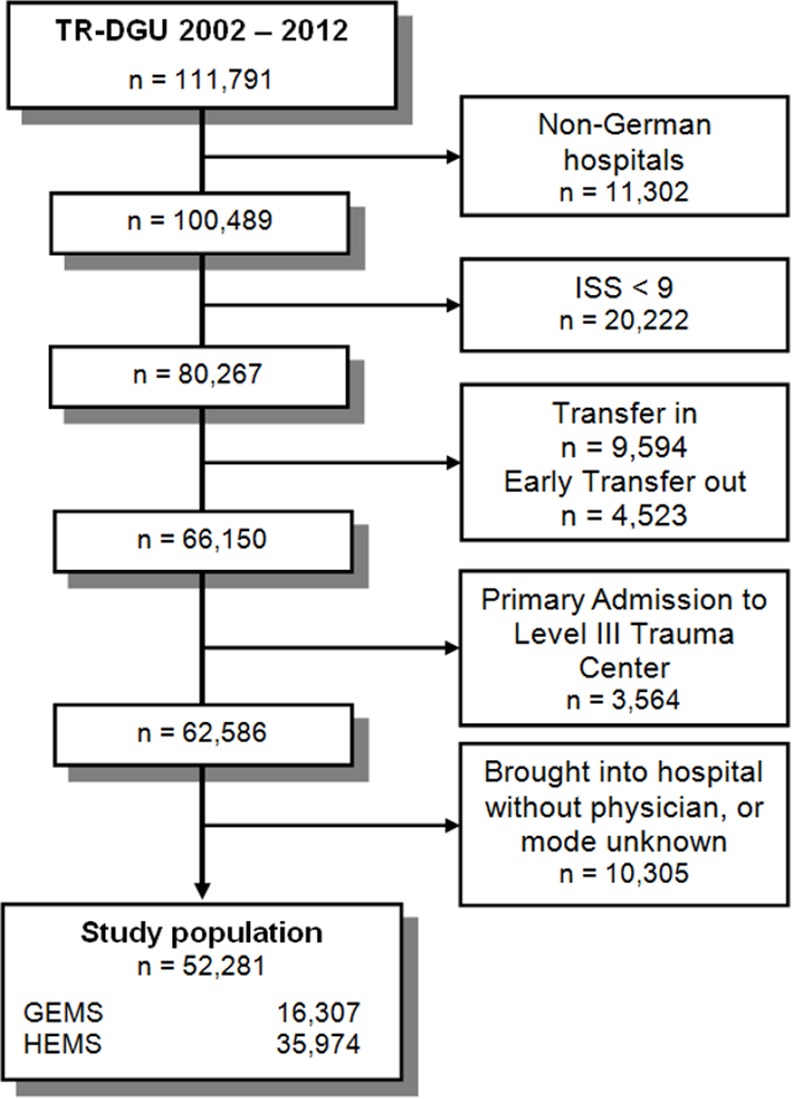
Study flow chart illustrating the selection of patients.